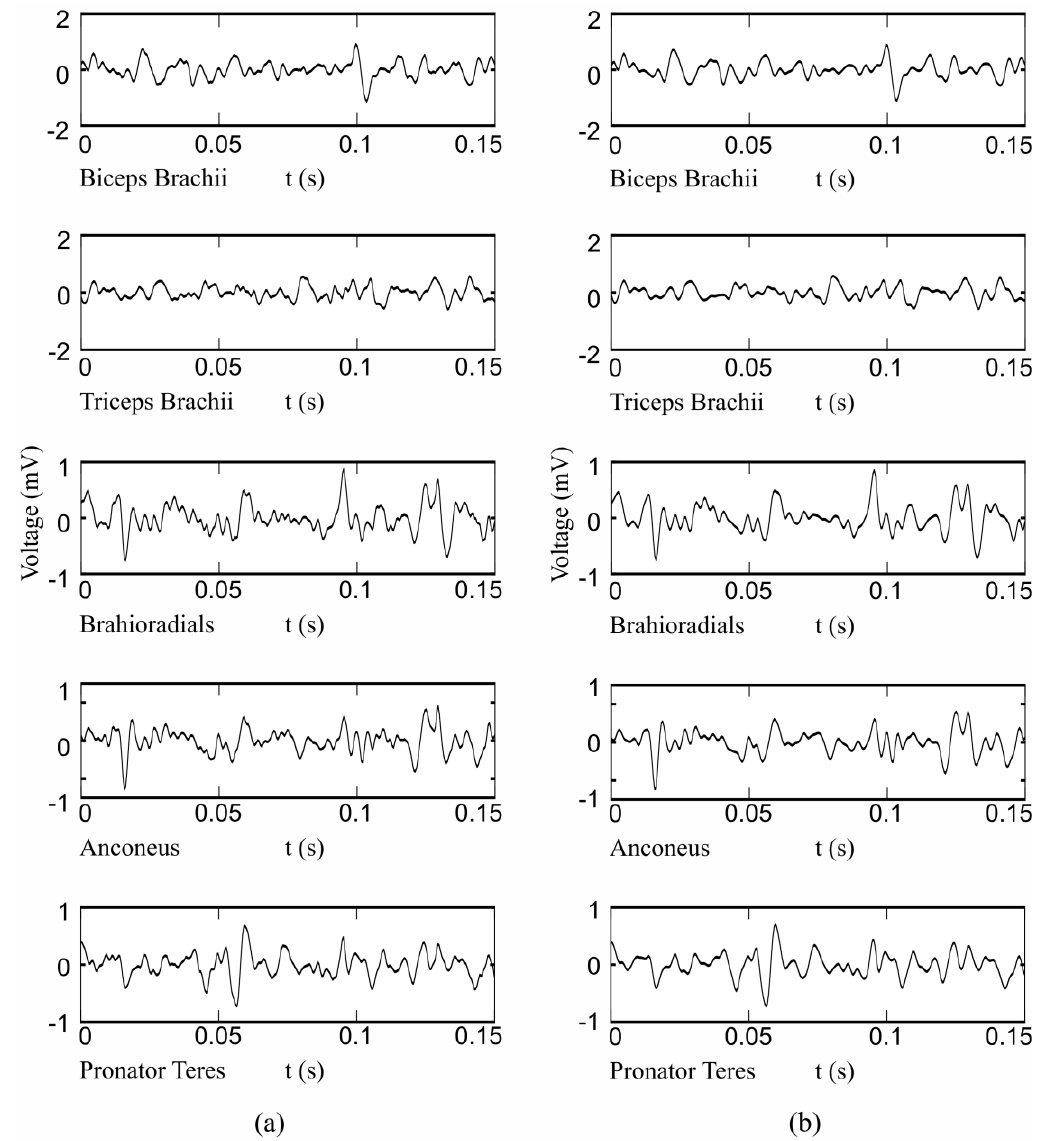
Figure B5. Example of recorded EMG signals from five muscles (biceps brachii, triceps brachi, brachioradialis, anconeus, bracioradialis, and pronator teres) during pronation. Figure shows ( a ) raw signals and ( b ) signals filtered using 4th order Butterworth filter with the cut-off frequencies of 15 Hz and 350 Hz.